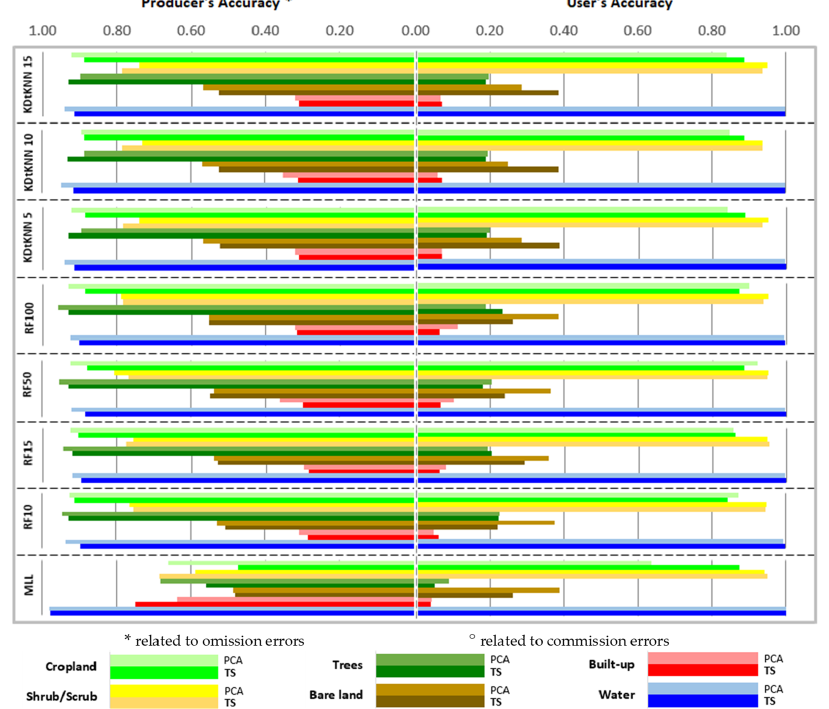
Figure 8. Class-specific assessment showing the user and producer accuracies of all classifications